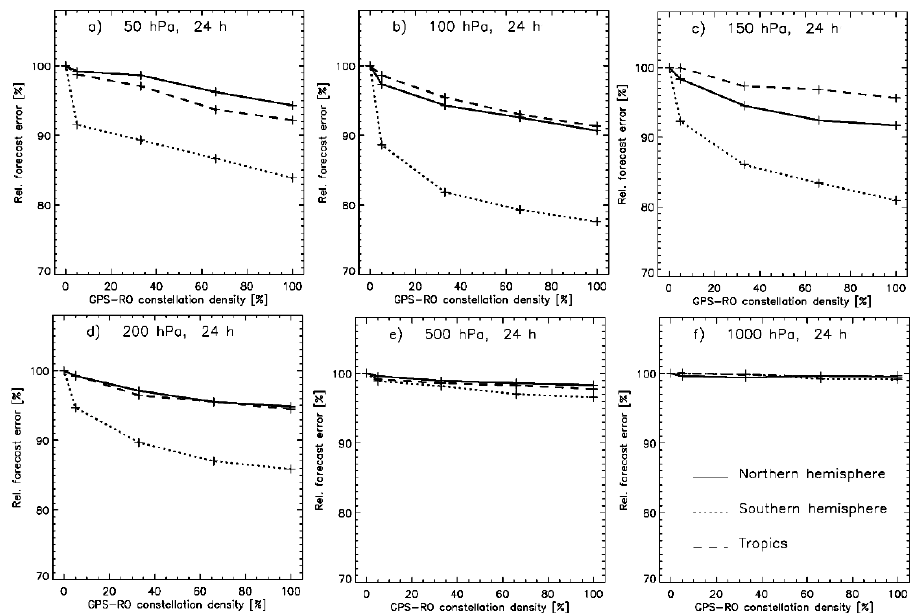
Figure 5. Sensitivity of height to the amount of RO data in NWP [45]. Dependence of 24-h temperature forecast. error relative to 0%-GPS-RO experiment (%) at ( a ) 50, ( b ) 100, ( c ) 150, ( d ) 200, ( e ) 500, and ( f ) 1000 hPa. The 24 h temperature relative forecast error, plotted along the y-axis, decreases with an increase in the GPS-RO data density. Above 500 hPa, more RO data induces less error, and the phenomenon in the stratosphere is more obvious than in the troposphere. The solid, dotted, and dashed lines indicate the results for the northern hemisphere, southern hemisphere, and tropics, respectively.